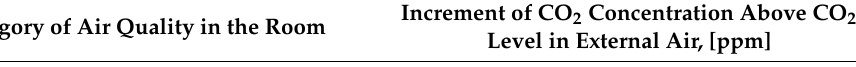
Table 1. Permissible values for carbon dioxide concentration to the air quality category, acc. to standard EN 16798-3 [31].